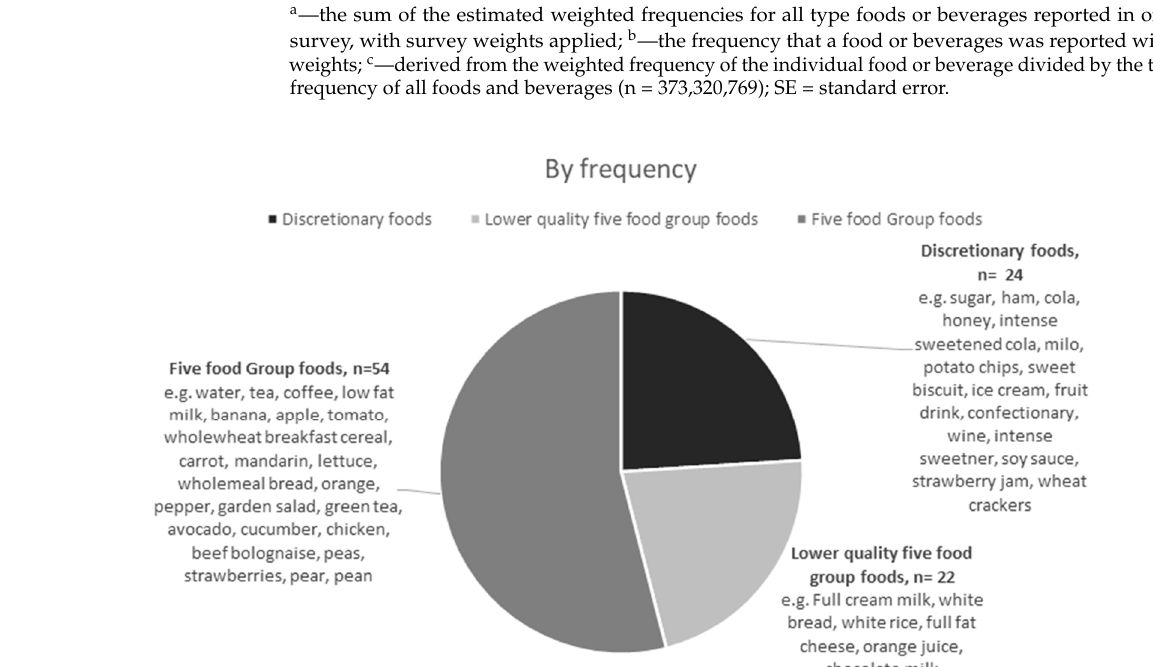
Figure 3. Number of the 100 most popular foods by minor food groups that were classified as five food group, lower quality five food group and discretionary foods, with a selection of the foods in each category listed. Differences between popularity by frequency of consumption and percentage energy contribution to the diet were also examined. When comparing the difference between ranking of foods by frequency to percentage energy contribution, tap water, black tea, black coffee and white sugar were ranked 1st, 3rd, 4th and 9th, respectively by frequency, but had a lower ranking by energy contribution of 4508, 167, 208 and 41. For red wine and lager or ale ‐ style beer (alcohol 4.6% v / v ), popularity by frequency of consumption was ranked 32nd and 33rd, respectively, but contribution to energy was at 2nd and 6th place. Cola soft drink on the other hand was ranked 8th place by energy contribution but was 18th place for frequency of consumption. White rice was 4th place by energy contribution but by frequency consumed ranked 29th.